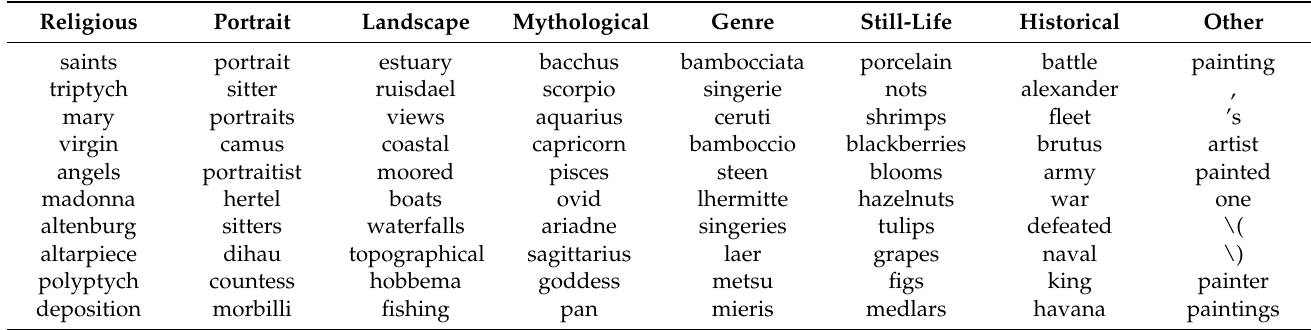
Figure 5. The t-SNE visualization of the second layer word embeddings. Each node represents the unique words in artistic comments. There are a total of 17,944 nodes (the number of words contained in artistic comments); we set the highest dimension as the word’s label. Table 3. Words with highest values for 8 classes using second-layer embedding. We show the top 10 words for each class. (Artists comments classified by